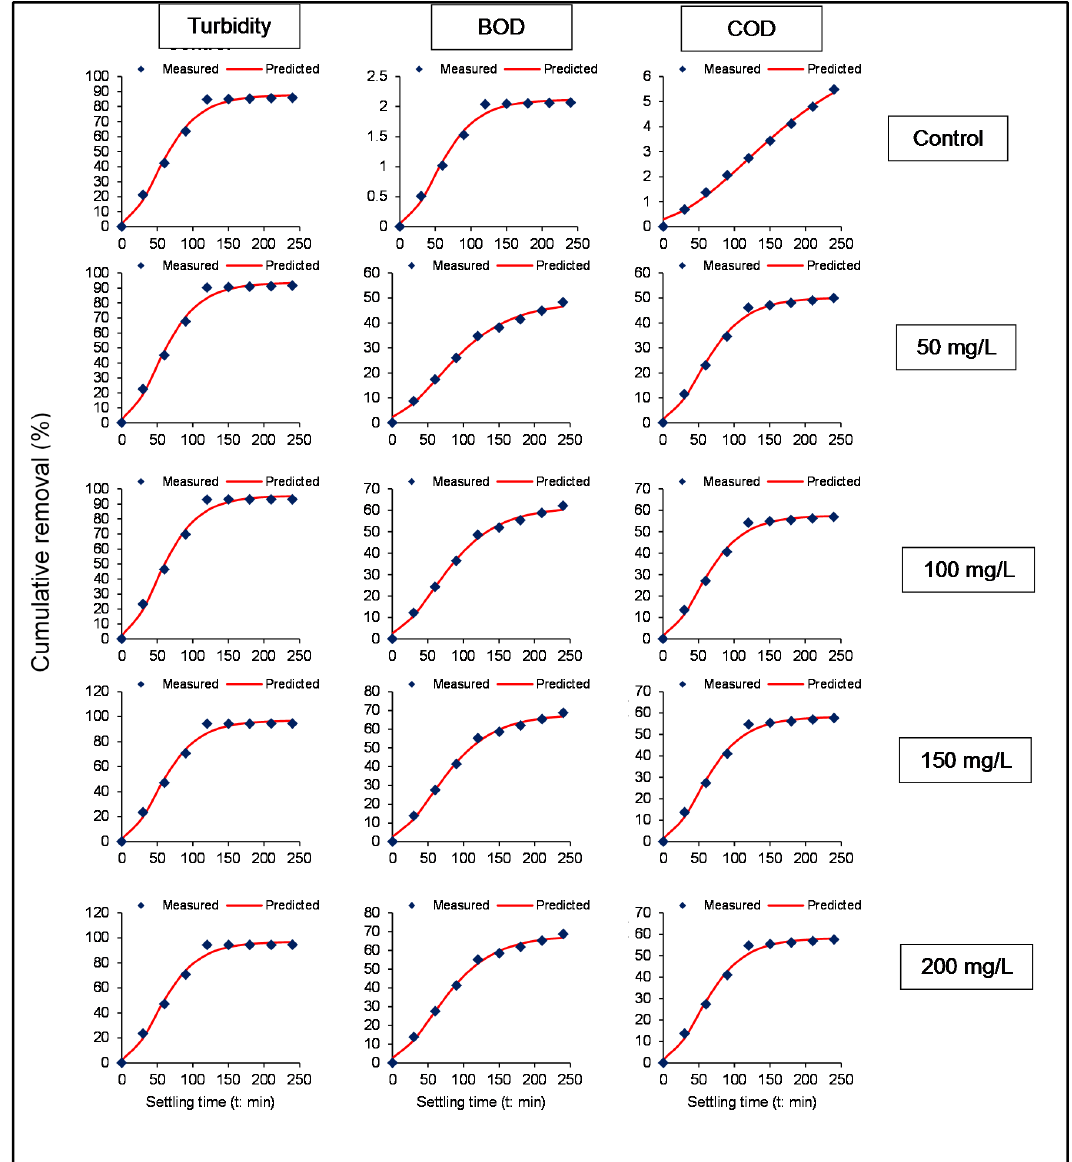
Figure 5. Experimental versus modified Gompertz model predicted cumulative removal (%) of turbidity, BOD, COD of municipal wastewater using MO coagulant.